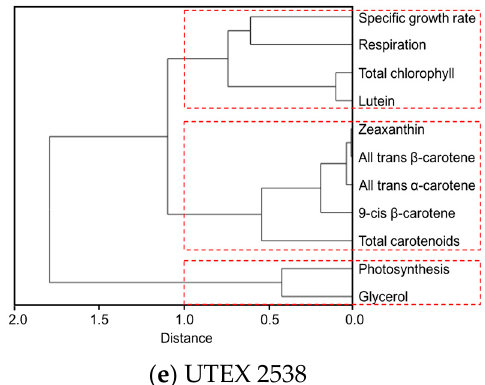
Figure 7. Cluster dendrograms of all-trans β -carotene, 9-cis β -carotene, glycerol, lutein, zeaxanthin, all-trans α -carotene, photosynthesis, respiration, total carotenoids, and total chlorophyll for all five Dunaliella strains cultivated at four light intensities. ( a ) CCAP 19/30; ( b ) DF15; ( c ) DF17; ( d ) DF40 and ( e ) UTEX 2538.